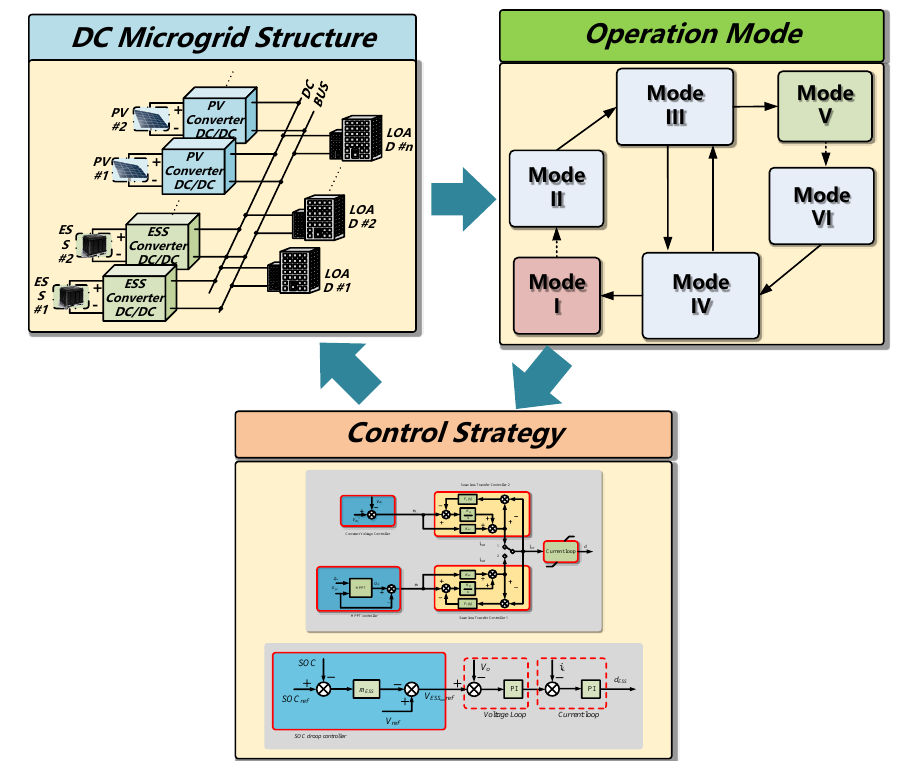
Figure 1. Diagram of a PV-ESS DC microgrid system.